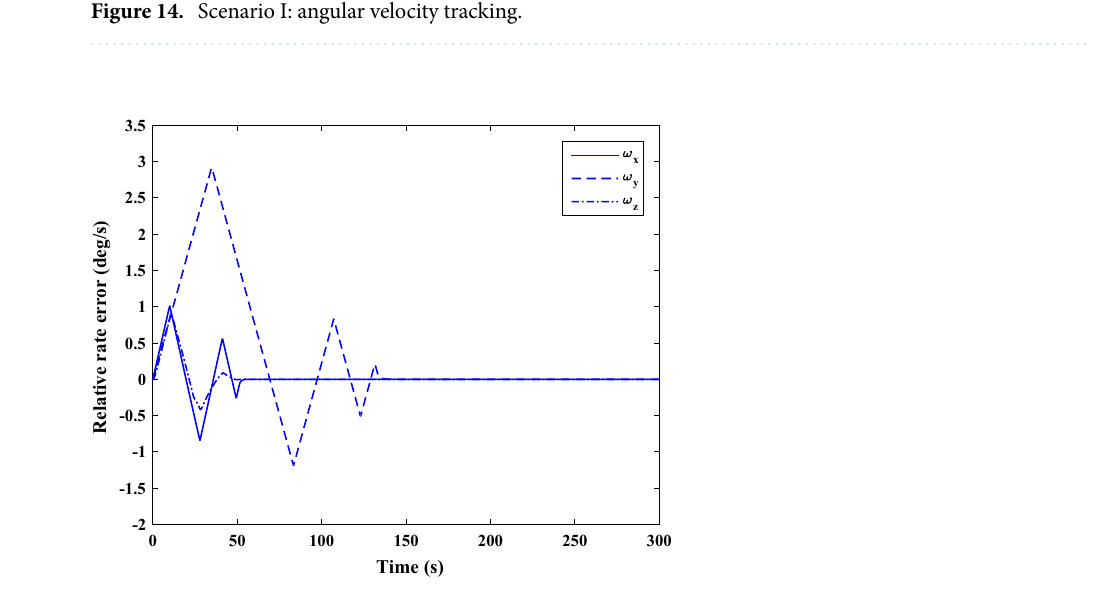
Figure 15. Scenario I: relative angular velocity